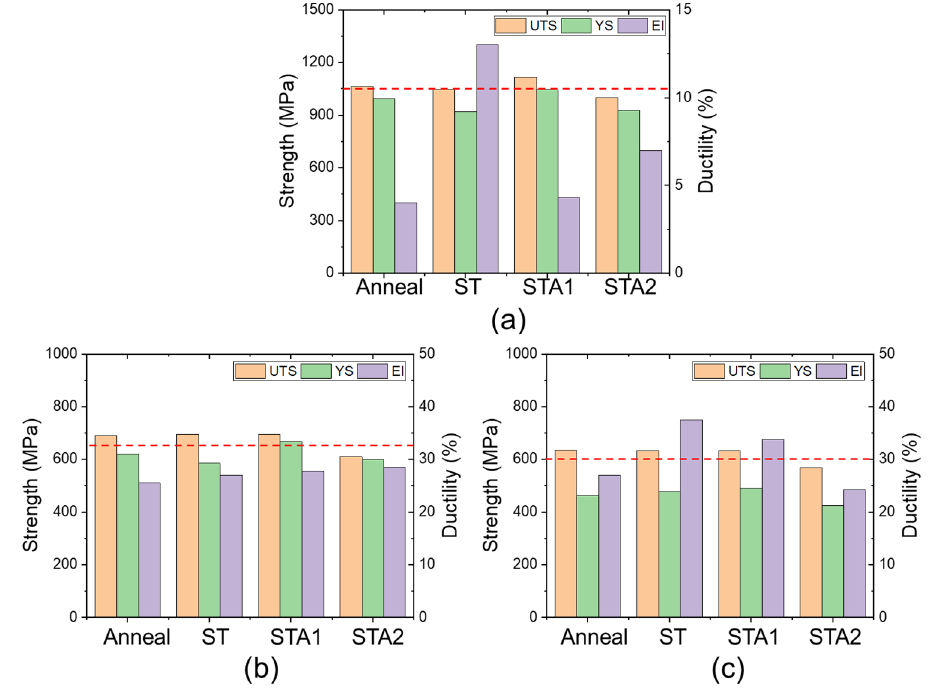
Figure 5. Tensile properties of the heat-treated samples tested at ( a ) room temperature, ( b ) 600 °C, and ( c ) 650 °C.